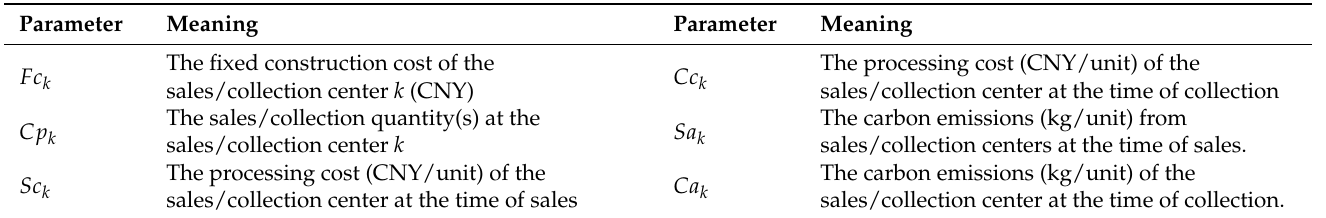
Table 4. Relevant parameters for the sales/collection center.